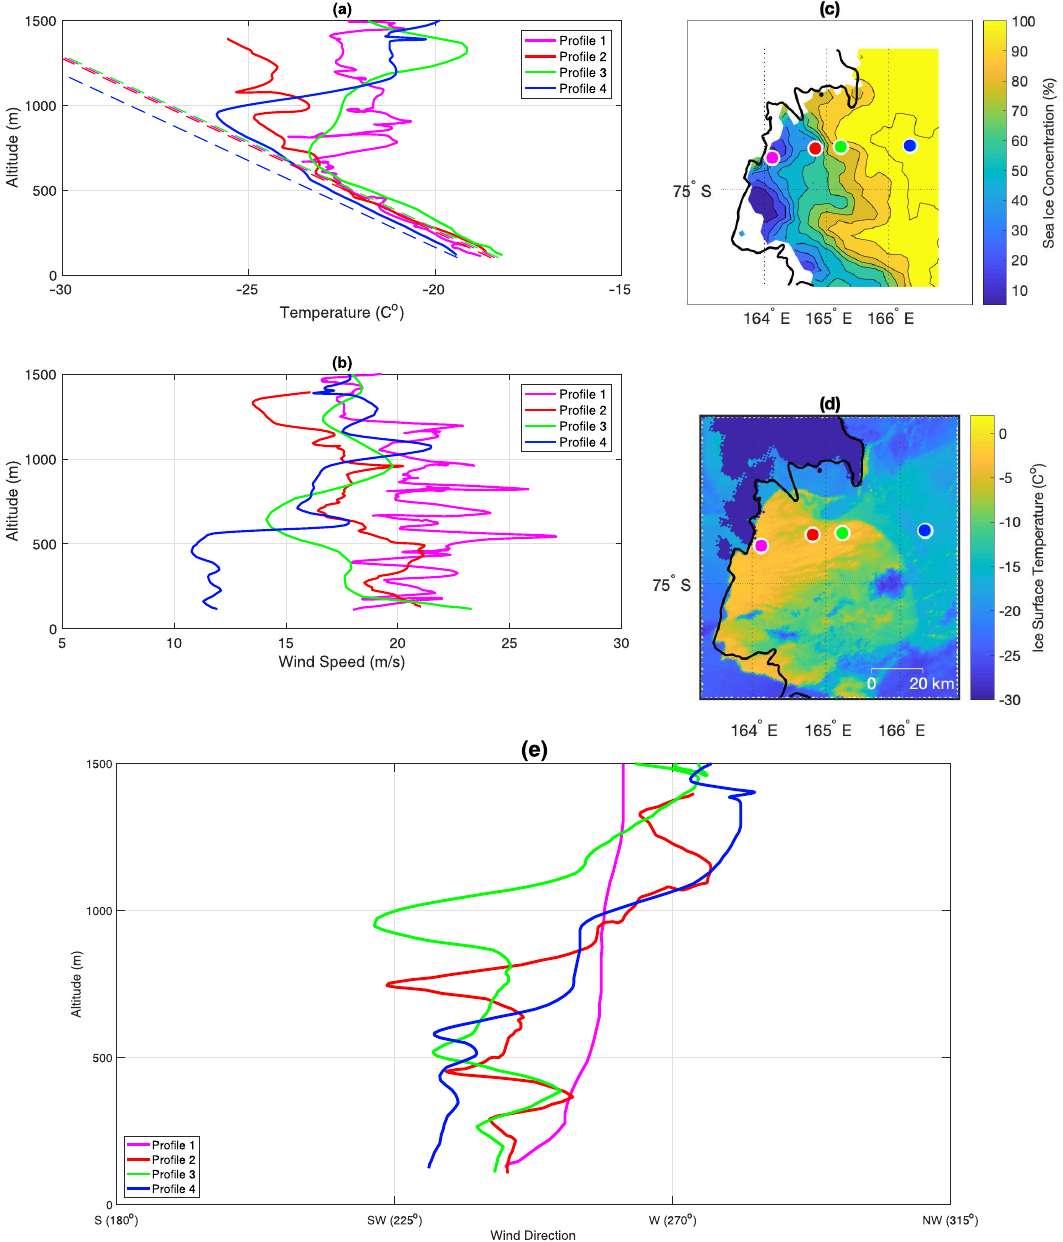
Figure 9. UAS Aerosonde measurements from 25th of September 2012. Subfigures labeled as in Figure 6. Profiles started at: 07:25 UTC (1); 08:33 UTC (2); 09:13 UTC (4); 11:47 UTC